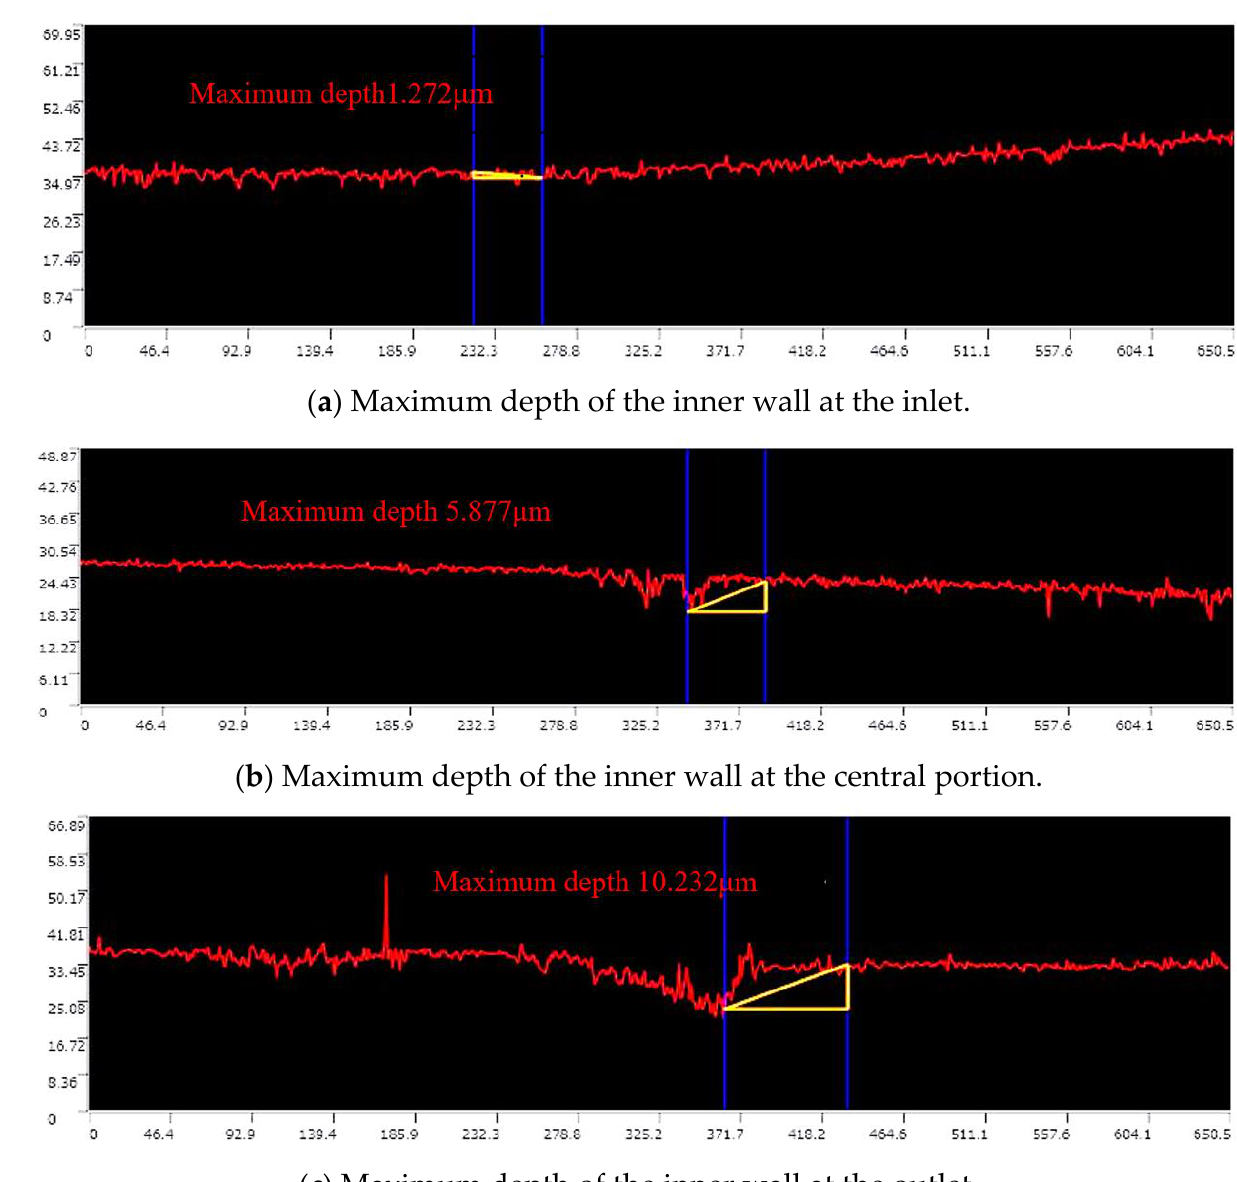
Figure 6. Microscopic profile of the inner wall of the pipe before erosion.